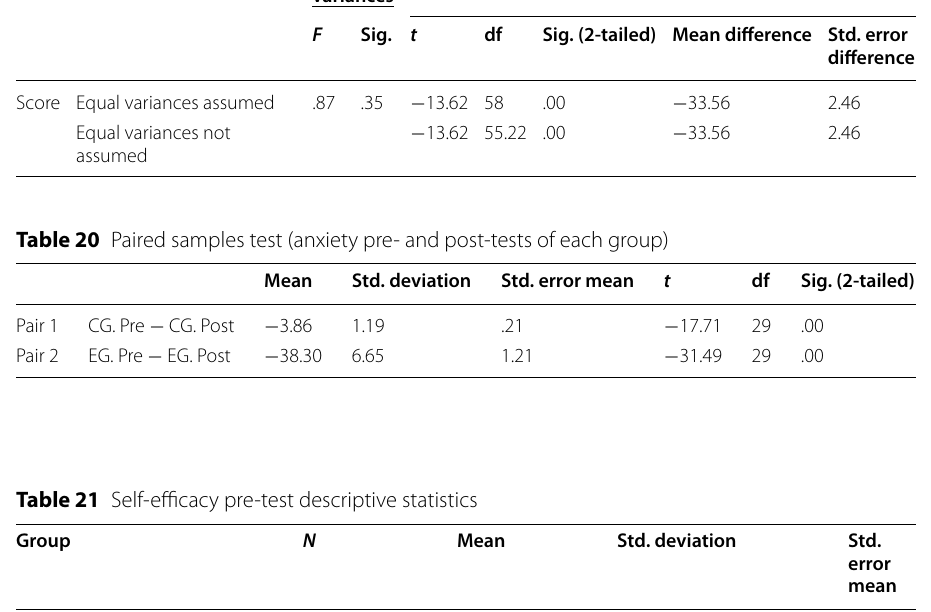
Levene’s t -test for equality of means test for equality of variances